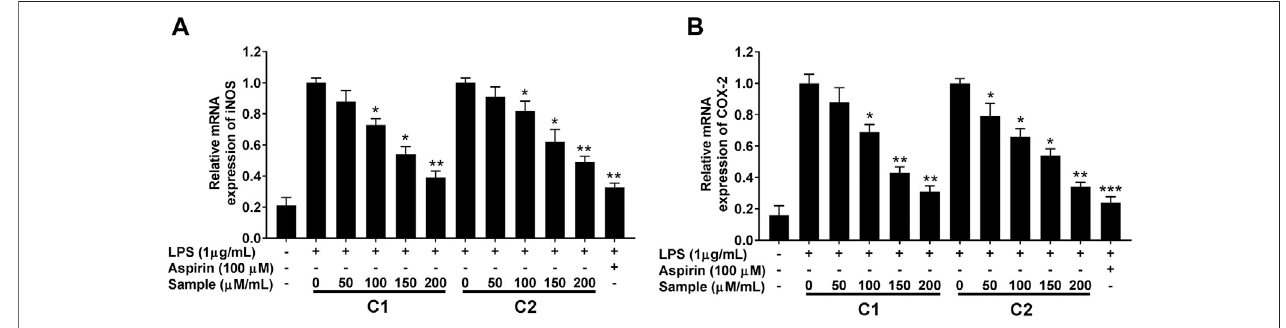
FIGURE 8 | Effects of puri fi ed compounds on iNOS (A) and COX-2 (B) genes expression in RAW264.7 cells. Cells were pretreated with the indicated concentrationsofpuri fi edcompounds for30 minandsimulatedwithLPS(1 μ g/ml)for24 h.Geneexpressionwasanalyzed byquantitative RT-PCR analysisusinggene speci fi c primers in a concentration-dependent manner. Values are the mean ± standard error of triplicate experiments. Values are the mean + S.E. of triplicate experiments. * p < 0.05, ** p < 0.01 and *** p < 0.001 for the comparison with the LPS-stimulated group. iNOS; nitric oxide synthase, COX-2;